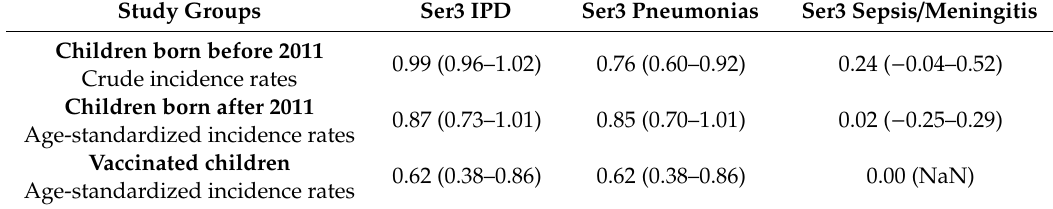
Table 1. Incidence rates (first row), age standardized incidence rates (ASR) (second and third row), and 95% confidence intervals of serotype 3 (ser3) invasive pneumococcal disease (IPD), ser3 pneumonias, and ser3 severe systemic infections (sepsis and meningitis) in Italian children under 8 years of age born before 2011, after 2011, and vaccinated with PCV13. Incidence rates refer to 1,000,000 person-years. NaN: not available number.